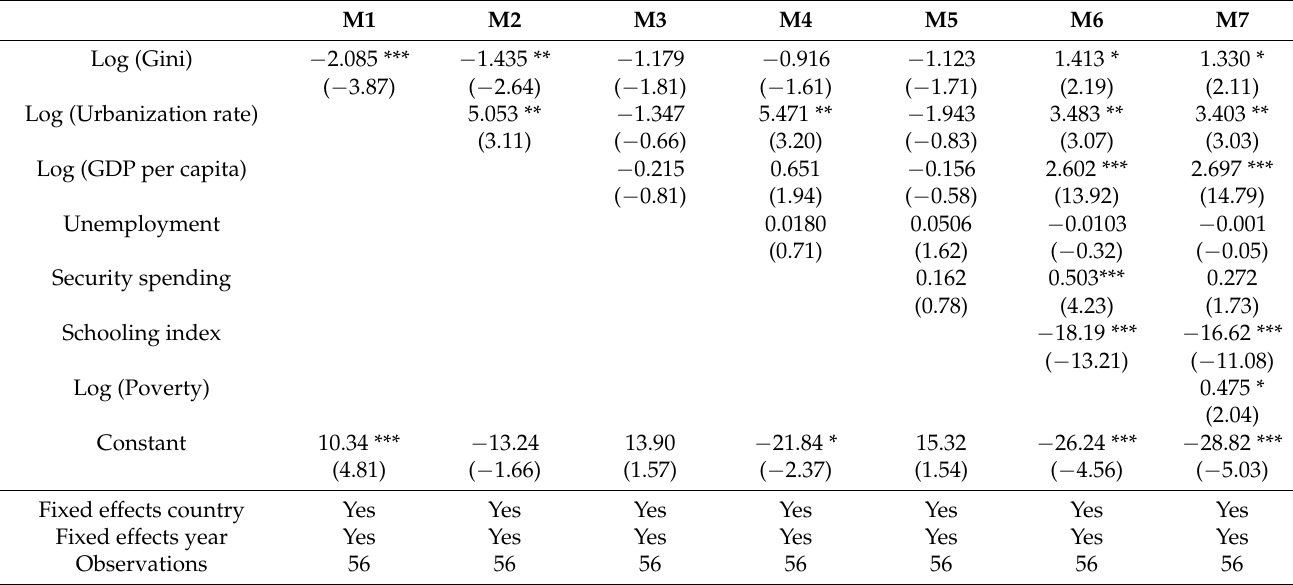
Table 7. Baseline regression of the GLS model with control variables for